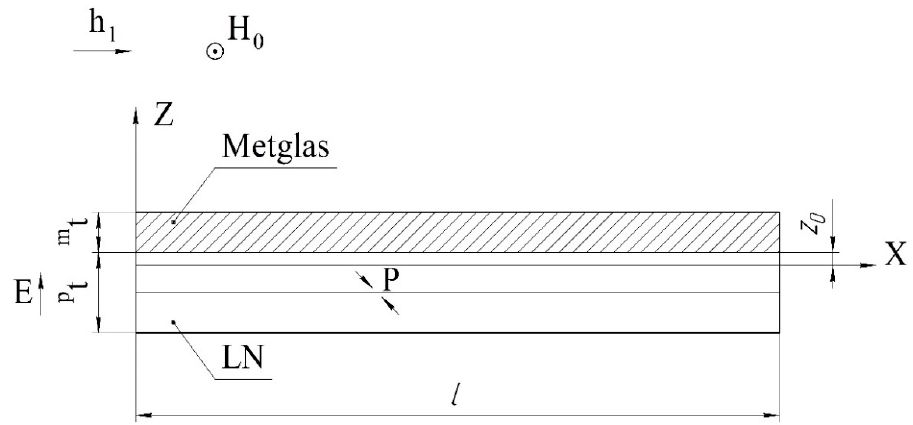
Figure 17. Asymmetric magnetoelectric composite with bimorth LiNbO 3 layer at torsional vibrations. The AC magnetic field is directed along the X axis, and the DC magnetic field is directed along the Y